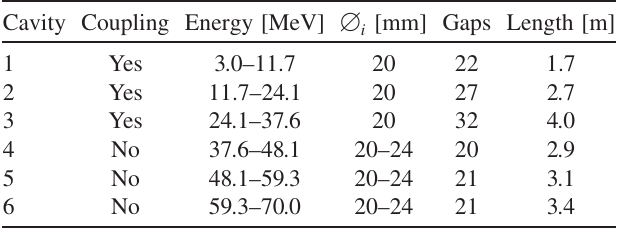
TABLE III. Main parameters of the CH cavities for the FAIR proton injector.